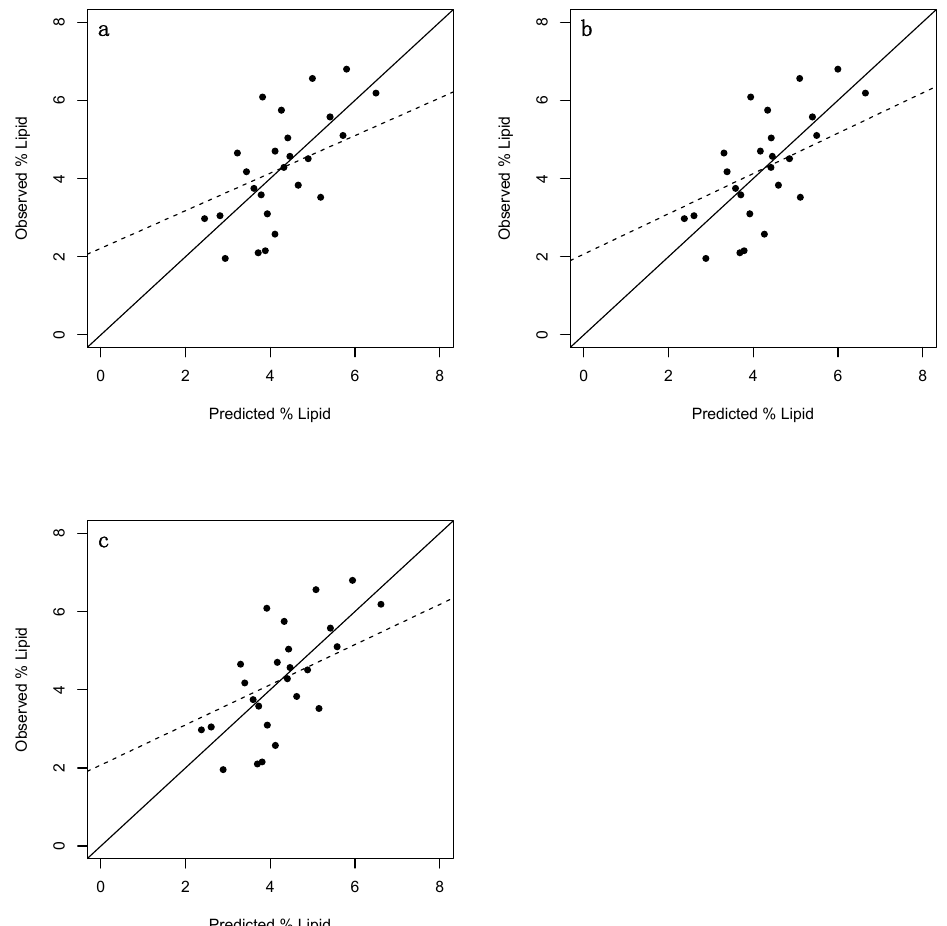
Figure 4. plots of observed vs. predicted percent lipid values of juvenile Cottus cognatus ( n = 25). ( a ) = Fulton’s condition factor; ( b ) = Fulton’s condition factor excluding stomach content and gonadal mass; ( c ) = Le Cren’s relative condition factor. Solid lines have a slope of 1 and an intercept of 0 thereby representing the ideal scenario where predicted = observed. Dashed lines denote represent linear regression lines. Table 4. models ranked to estimate which indirect condition index best approximates percent lipid in juvenile Cottus cognatus ( n = 25). PL = percent lipid; Fulton’s K = Fulton’s condition factor; Ks = Fulton’s condition factor excluding stomach content and gonadal mass; Kn = Le Cren’s relative condition factor; R 2 = coefficient of determination; RMSE = root mean square error of the regression; AIC c = bias-adjusted Akaike Information Criterion for small sample sizes; Δ AIC c = AIC c of alternative model minus that of the top model; w i = Akaike weight; ER = evidence ratio); LOOCV R 2 = coefficient of determination from cross- validation; LOOCV RMSE = root mean square error from cross-validation. The coefficients of each predictor were significantly different from 0 ( p = <0.05).